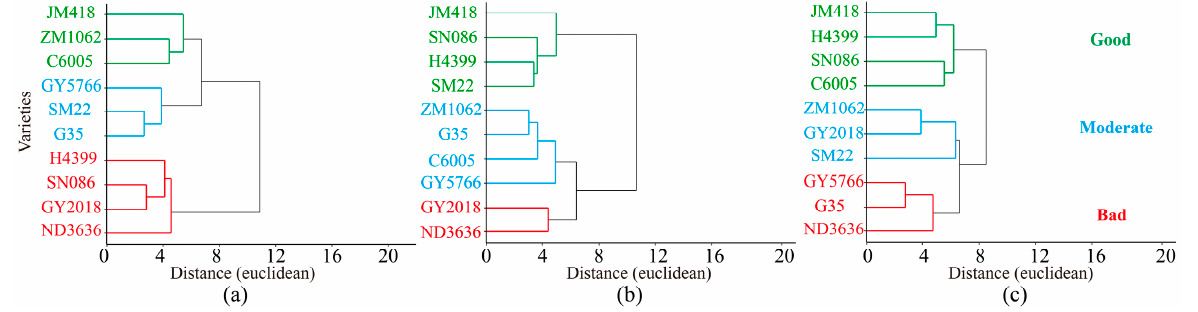
Figure 5. Dendrogram of wheat genotypes based on physiology traits (SPAD, LAI, Pn, Tr, Cn and biomass) of all stages in different water treatment: ( a ) W0, no irrigation during the growing season, ( b ) W1, irrigation at jointing, ( c ) and W2, irrigation at jointing and anthesis, they were divided into three groups. Three colors represent different drought resistant performance categories.